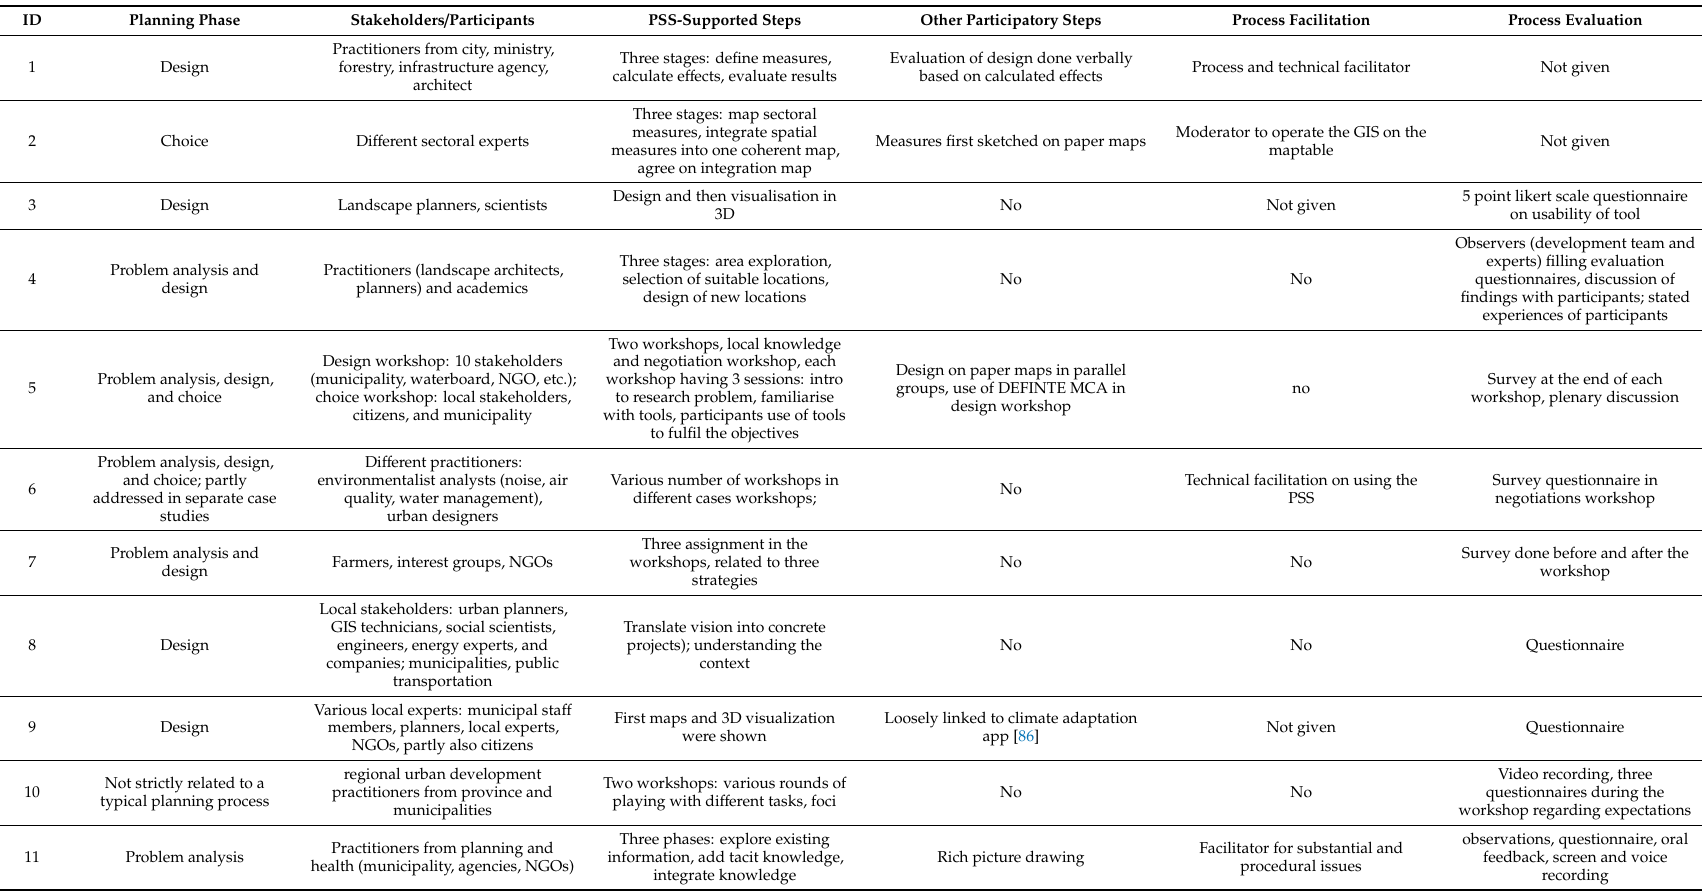
Table A3. Participatory